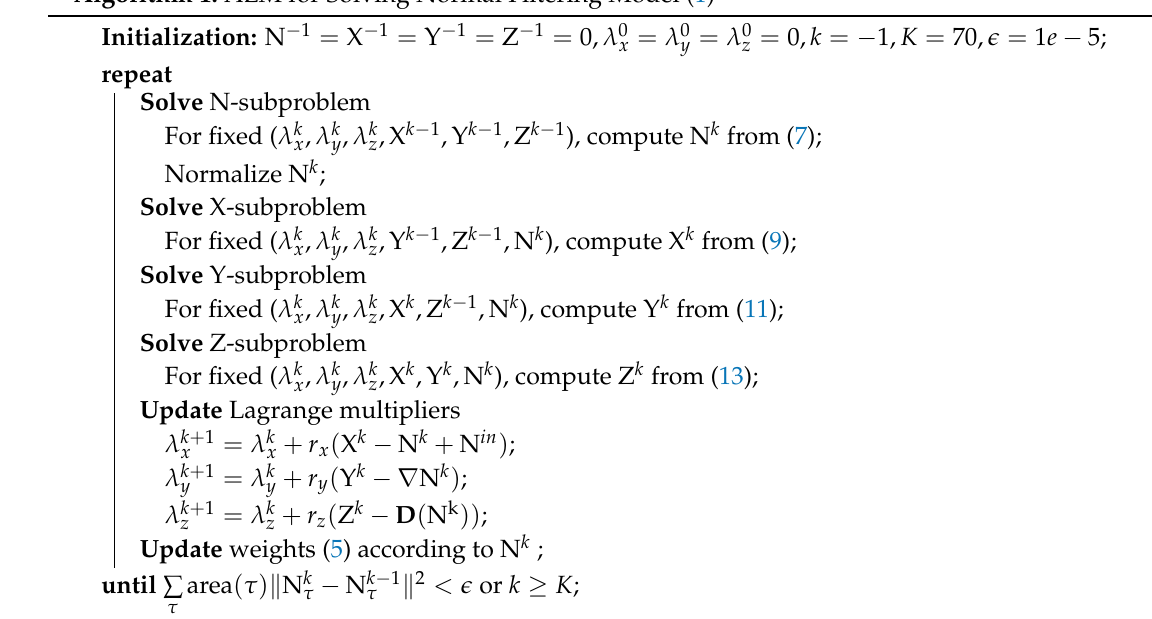
Algorithm 1: ALM for Solving Normal Filtering Model